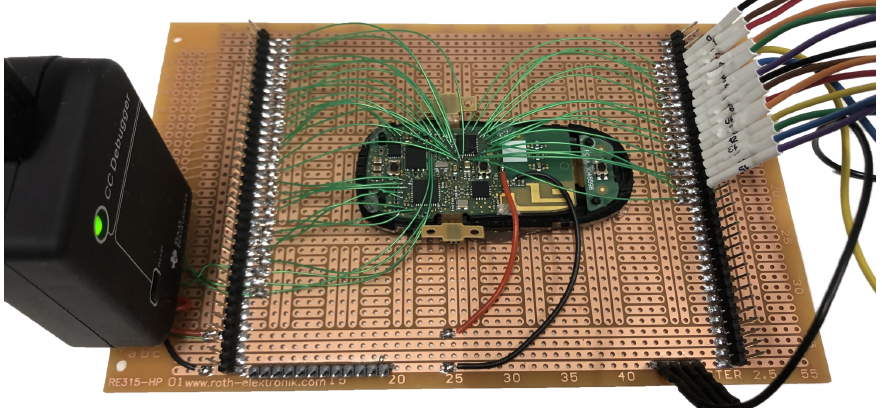
Figure 4: A Model X key fob prepared to provide easy access to inter-chip communication channels that can be analyzed by connecting a logic analyzer. Additionally, we added